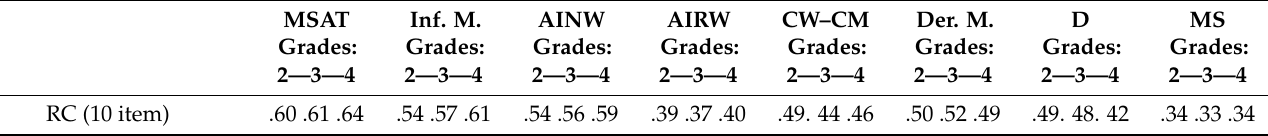
Table 7. Correlations among different aspects of morphological awareness and reading